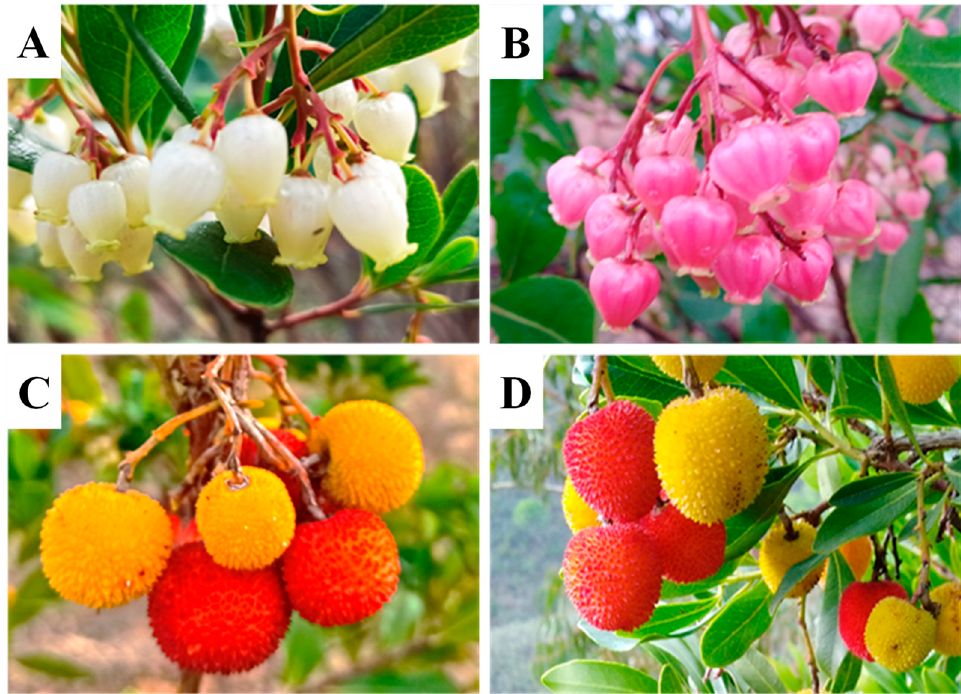
Figure 1. Phenotypic variability within the strawberry tree ( Arbutus unedo L.) germplasm collection. ( A , B ) Flowers with different colors and shapes. ( C , D ) Fruits with different forms. Pre-ripened fruits (yellow) and ripened fruits (red).